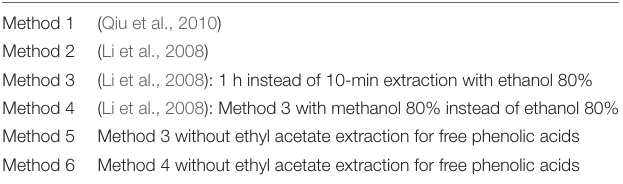
TABLE 1 | Summary of extraction trials for free, conjugated, and bound phenolic acids (PA) performed on Armorik and Ggolden varieties. Method 1 (Qiu et al., 2010) Method 2 (Li et al.,